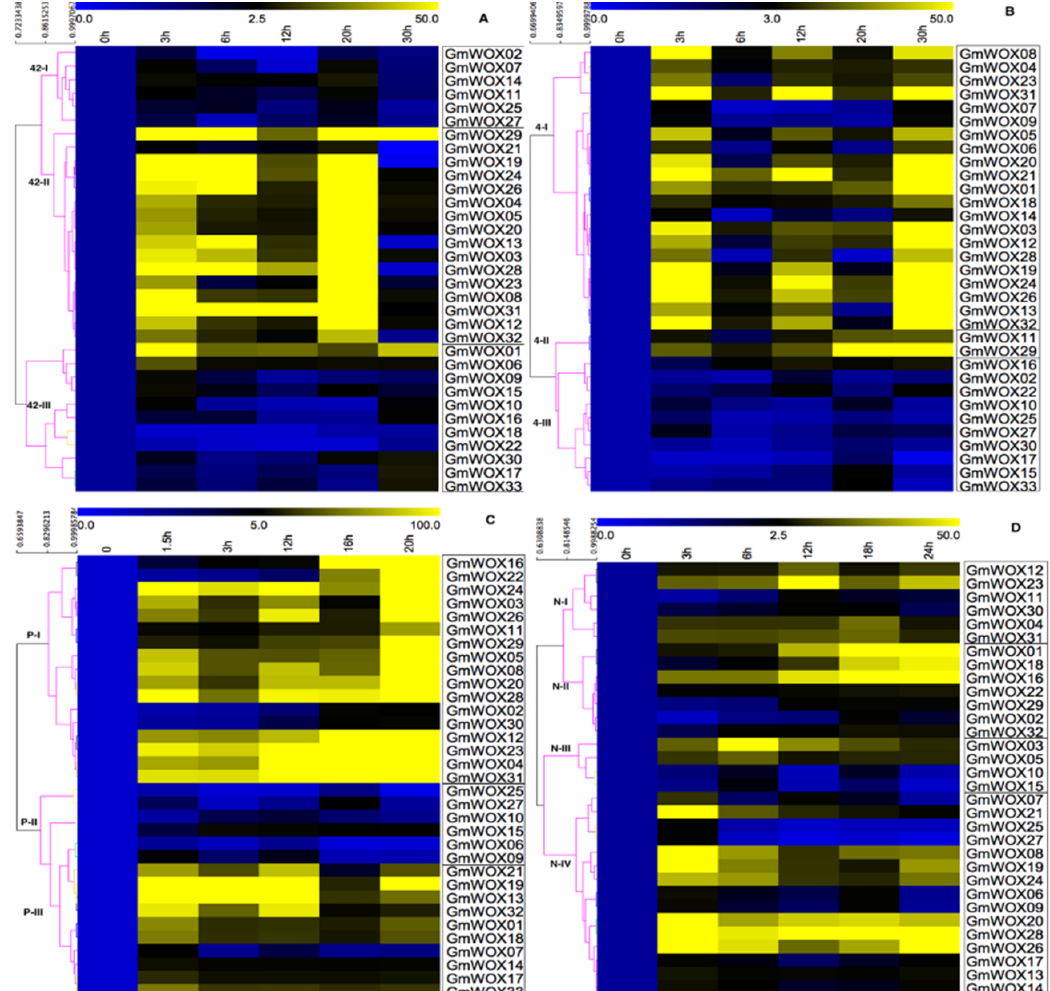
Figure 6. Expression analysis of GmWOX genes in response to abiotic stresses. Two-week-old soybean seedlings were exposed to stress treatment as indicated below. Gene expression analysis was conducted by qRT-PCR using gene-specific primers. ( A ) Heat stress, ( B ) Cold stress, ( C ) Drought stress, ( D ) Salt stress.